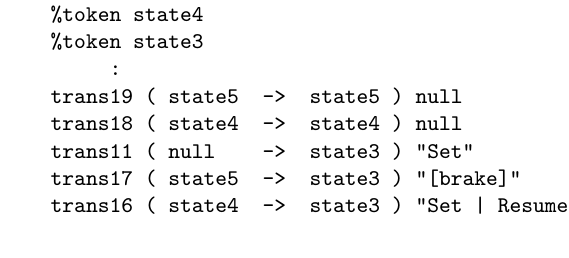
Fig. 4. Intermediate listing for code in Fig.